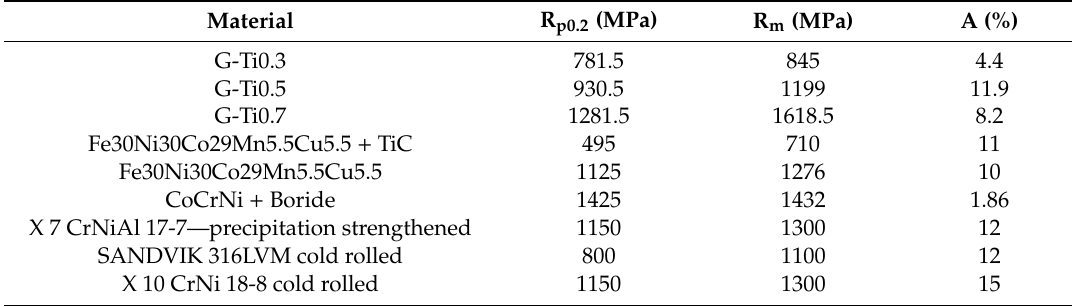
Table 8. The comparison of mechanical properties of produced Ni 1,5 Co 1,5 CrFeTi X alloys with other similar materials. The values for di ff erent PM materials are taken from Refs. [9,37]. The values of wrought steels are taken from https: // www.materials.sandvik /